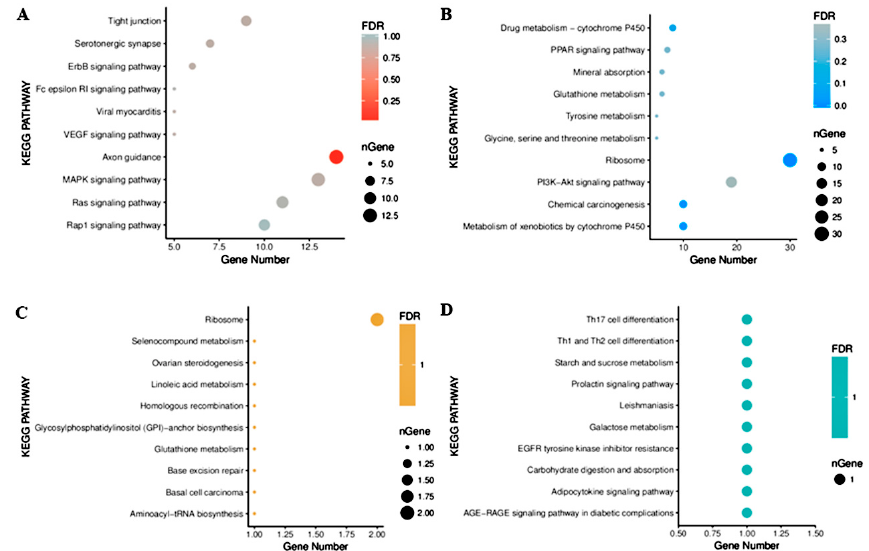
Figure 4. Functional enrichment analysis of DEGs and DEMs. ( A ) Significantly enriched pathways